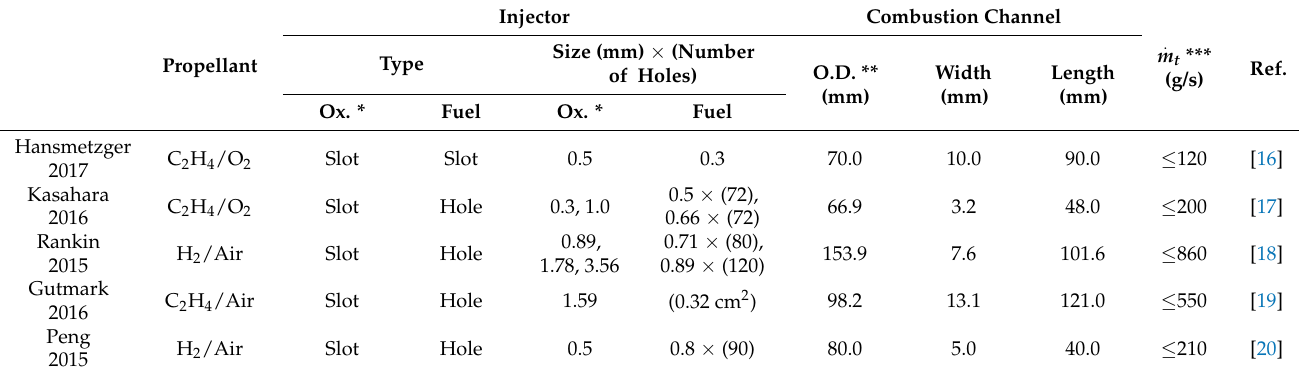
Table 3. Specifications of RDE models developed by other research groups.